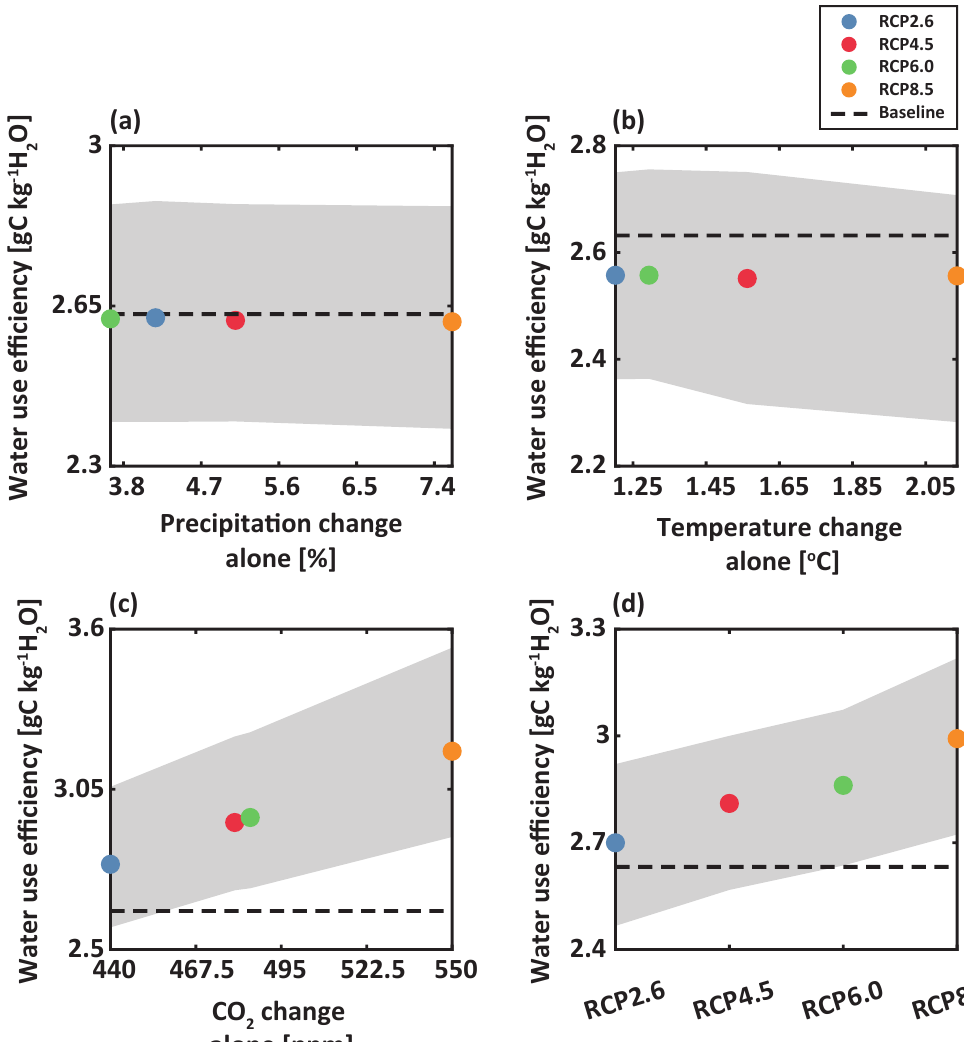
Figure 7. Projected water use efficiency for the scenario of ( a ) precipitation change alone, ( b ) temperature change alone, ( c ) CO 2 change alone, and ( d ) all together under RCP 2.6 (blue), 4.5 (red), 6.0 (green), and 8.5 (orange) for the 2050s (from 2036 to 2065) compared with baseline. Shaded areas represent the 25th to 75th percentile intervals. The variables at baseline are shown in dashed